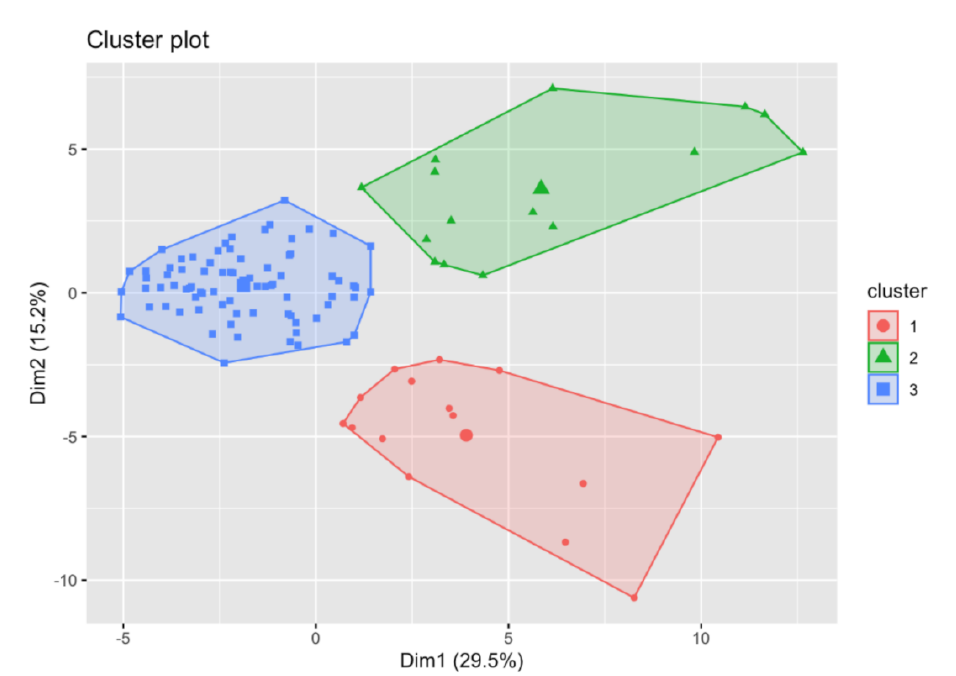
Figure 4. Results of cluster analysis mapped on 2D PCA surface. Points represent observations of three clusters with linear combination